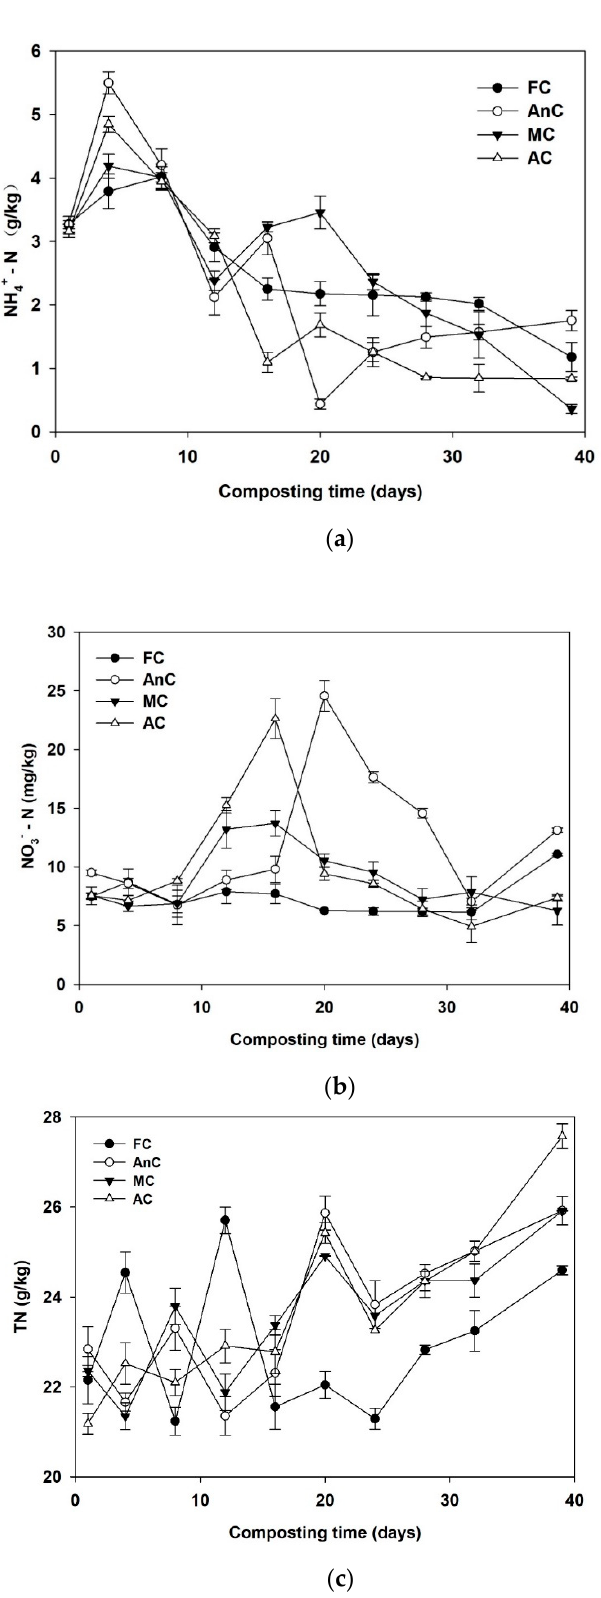
Figure 5. Changes in NH 4 + -N ( a ), NO 3 − -N ( b ), and TN ( c ) concentrations in the compost material during dairy manure composting. FC—farmer compost; AnC—anaerobic compost; MC—mixed compost; AC—aerobic compost.